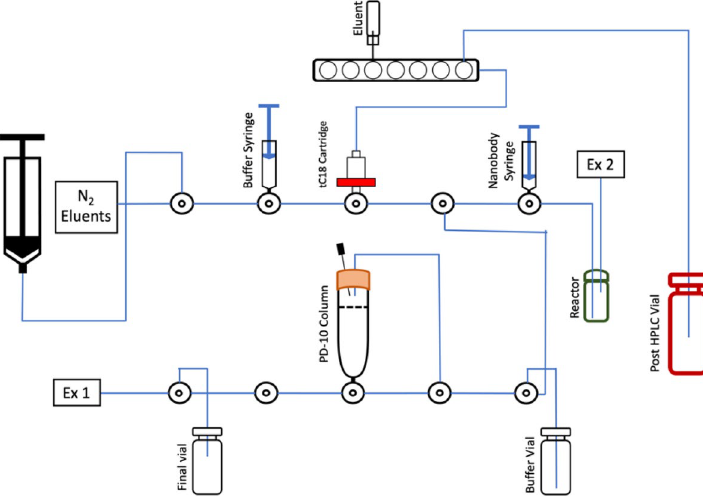
Figure 6. Layout of the module for [ 18 F]SFB labeled nanobody and purification.